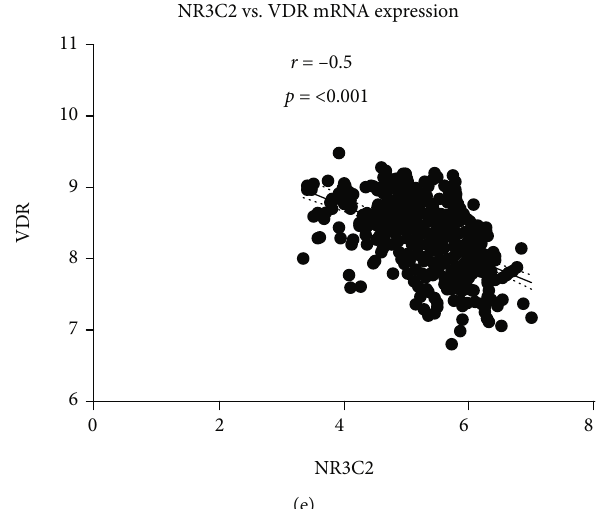
Figure 2: NR3C1, NR3C2, and VDR mRNA expression levels in the blood of subjects with severe asthma, moderate asthma, and nonasthmatics. Data was collected from the U-BIOPRED study (GSE69683).